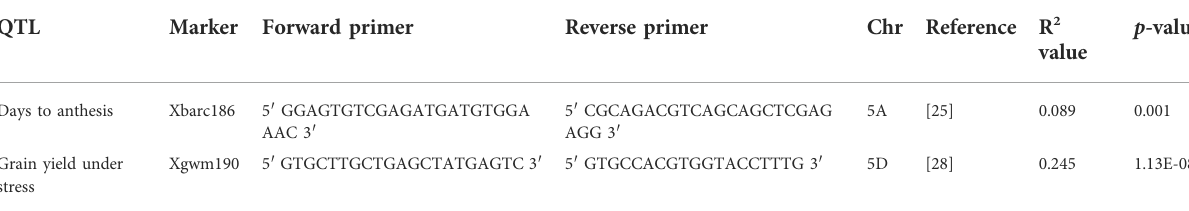
TABLE 1 Details of the markers used in the foreground selection of backcross-derived